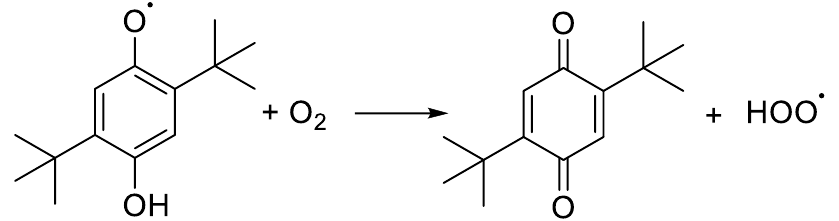
Figure 5. Relation between R inh and IP divided by the molar antioxidant concentration (in arbitrary units). Antioxidants with undefined IP were